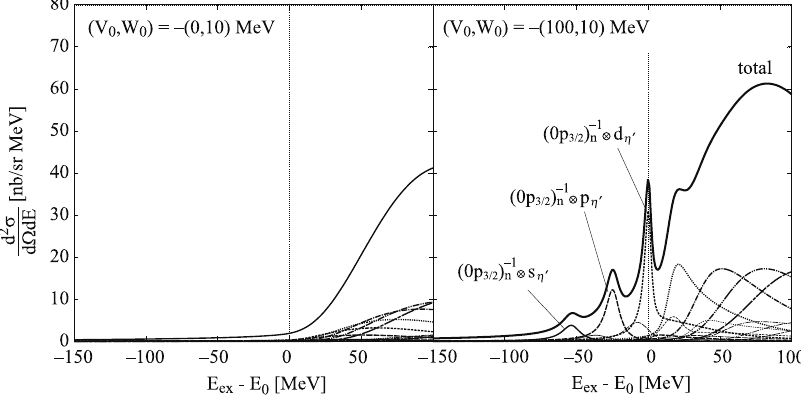
Fig. 1. Calculated spectrum of 12 C( p ; d ) 11 C (cid:10) (cid:17) 0 reaction for the formation of the (cid:17) 0 -nucleus systems with the proton kinetic energy T p = 2 : 5 GeV and the deuteron angle (cid:18) d = 0 (cid:14) as a function of the excited energy E ex [9]. E 0 is the (cid:17) 0 production threshold. The depth of the (cid:17) 0 -nucleus optical potential is (a) ( V 0 ; W 0 ) = (cid:0) (0 ; 10) MeV, and (b) ( V 0 ; W 0 ) = (cid:0) (100 ; 10) MeV. The thick solid line shows the total spectrum and dashed lines indicate subcomponents. The neutron-hole states are indicated as ( n ‘ j ) (cid:0) 1 and the (cid:17) 0 states as ‘ (cid:17) 0 n